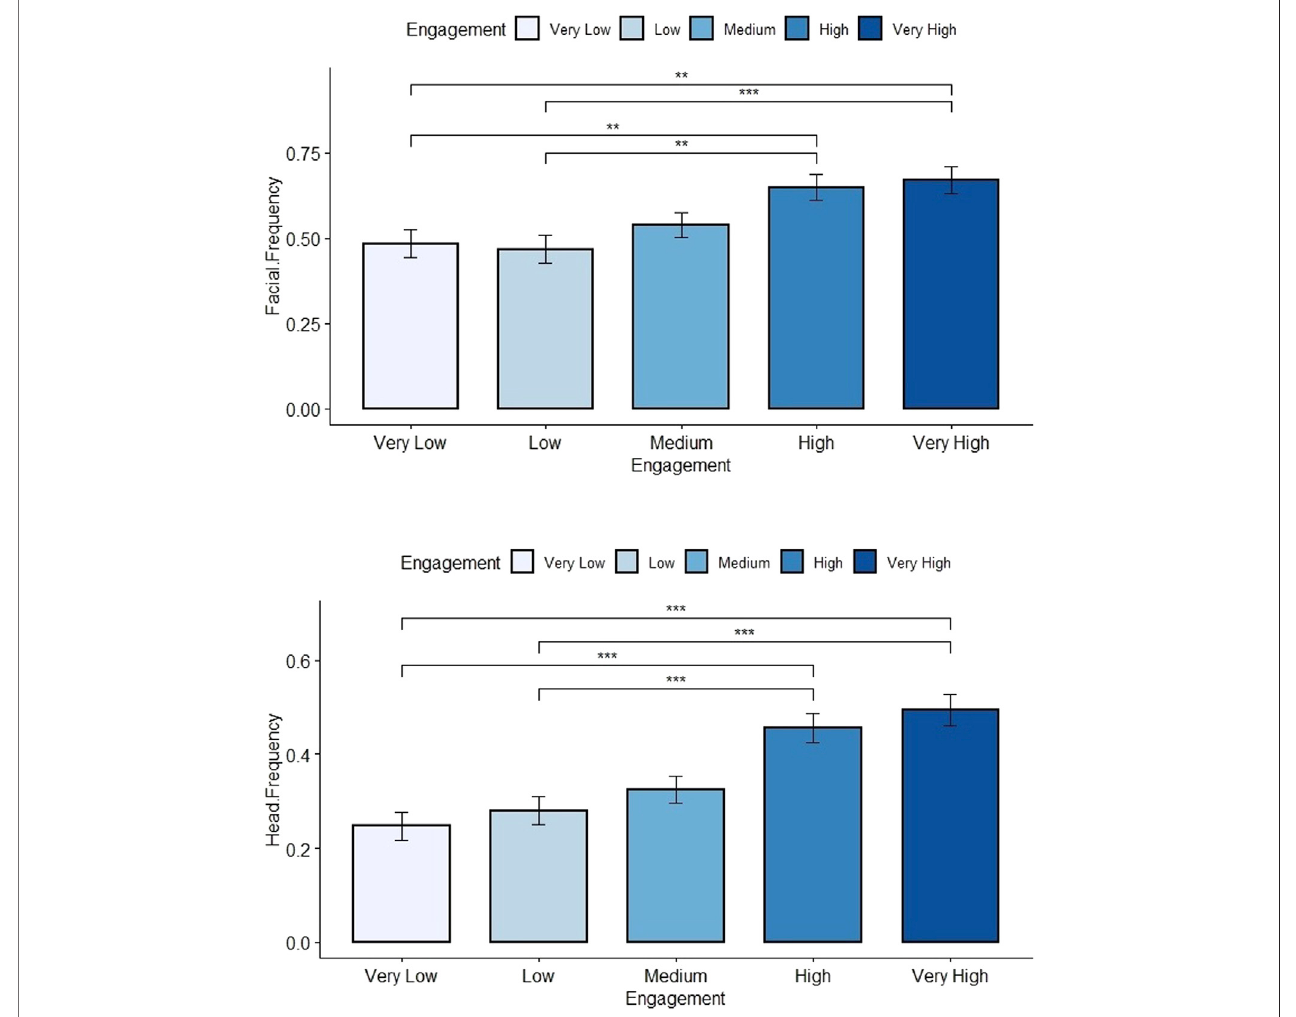
FIGURE 4 | Distribution plots of the facial expressions and head movements frequency depending on the engagement (Arousal) levels. Signi fi cant results with the Medium Engagement level was removed for clarity purpose, Table 2 for details.